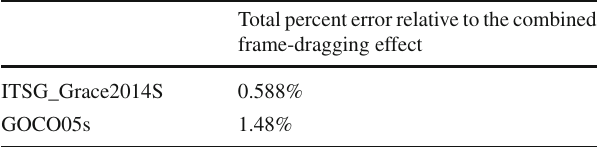
Table 3 Total error (sum of each absolute value) propagated into the combinationofthenodes ofLAGEOS, LAGEOS 2andLARESrelative to the combined frame-dragging effect of LAGEOS, LAGEOS 2 and LARES (about 50.465